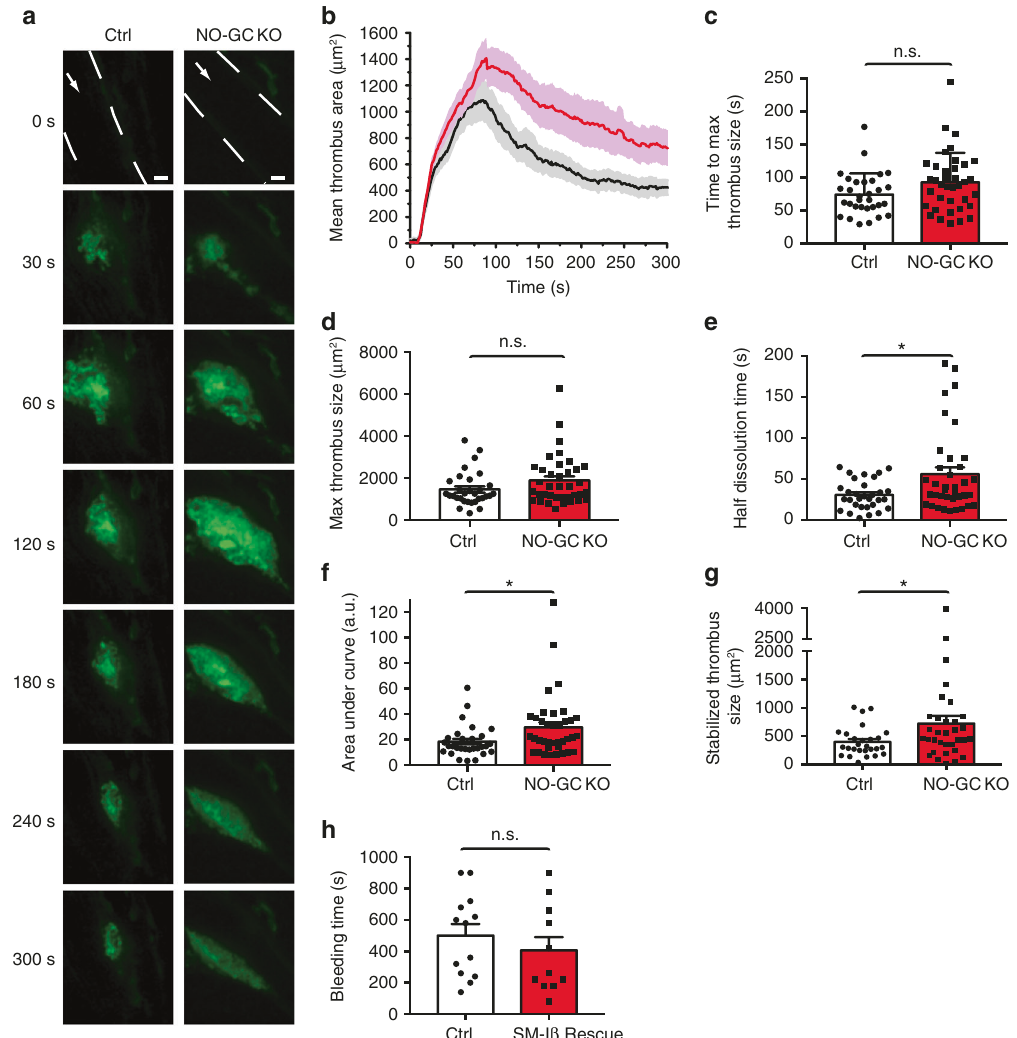
Fig. 4 Increased thrombosis and thrombus dissolution time in platelet-speci fi c NO-GC knockout mice. a – g Laser-induced thrombosis in cremaster arterioles of control mice (Ctrl) ( cGi500-L2 fl / fl ; Pf4-Cre tg/ + ; NO-GC β 1 + / fl ) and platelet-speci fi c NO-GC β 1 knockout mice (NO-GC KO) ( cGi500-L2 fl / fl ; Pf4-Cre tg/ + ; NO-GC β 1 fl / fl ). a Representative fl uorescence (YFP) images of platelet thrombi at indicated time points after laser injury. Vessel walls are outlined by broken white lines, and white arrows indicate the direction of blood fl ow. Scale bars, 10 μ m. b Pro fi le of thrombus growth shown in a depicted as thrombus area over time in Ctrl (black) and NO-GC KO (red) mice. Various aspects of thrombus formation were evaluated: c Time to maximum thrombus size; d Maximal thrombus size; e Thrombus half dissolution time, i.e. the time required after peak maximum to decline to 50%; f Area under curve, which re fl ects integrated thrombus size over time; g Size of stabilized thrombi at the end of the experiment (300 s). Data are shown as mean ± SEM; n = 31 and 37 thrombi in b – f generated in 10 Ctrl and 7 NO-GC KO mice, respectively; n = 27 and 33 thrombi in g generated in 10 Ctrl and 7 NO-GC KO mice, respectively. h Tail bleeding time (mean ± SEM) in control mice ( SM22 + /I β ; cGKI + /L − ) and SM-I β rescue mice lacking cGKI in platelets ( SM22 + /I β ; cGKI L − /L − ) ( n = 13 and 11 mice, respectively). Statistical signi fi cance was analyzed in c – g using Student ’ s t -test (or Welch t -test for samples with non-equal variances) and in h using Mann – Whitney U test. * P < 0.05; n.s., not signi fi